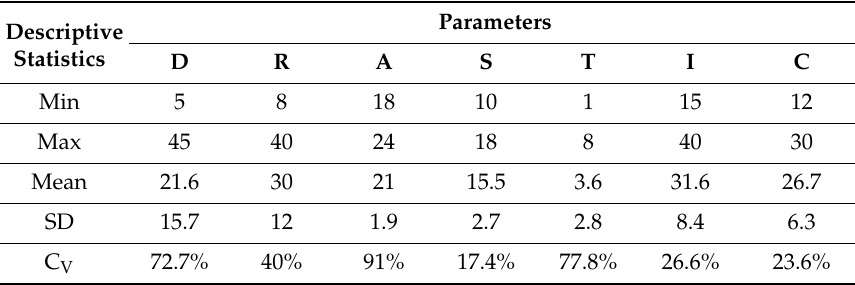
Table 5. Statistics of the DRASTIC parameters map.